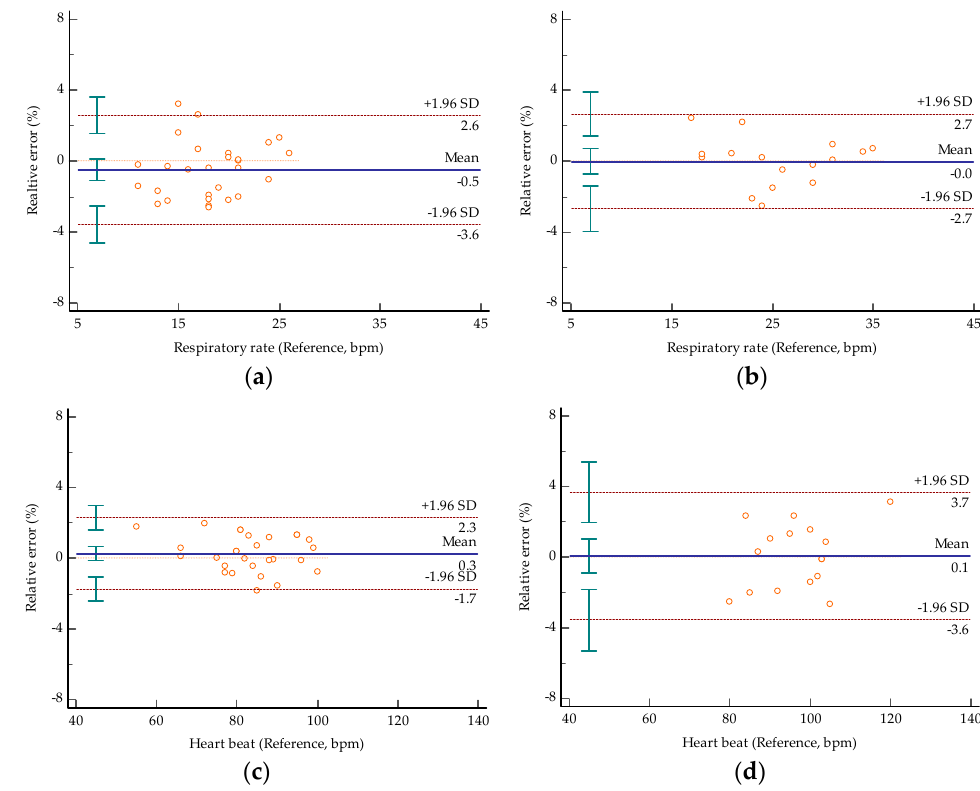
Figure 14. Bland–Altman plots of the values obtained by the proposed method against the reference values obtained by the smart bracelet: ( a ) respiratory rate of Group #1; ( b ) respiratory rate of Group #2; ( c ) heart rate of Group #1; ( d ) heart rate of Group #2.